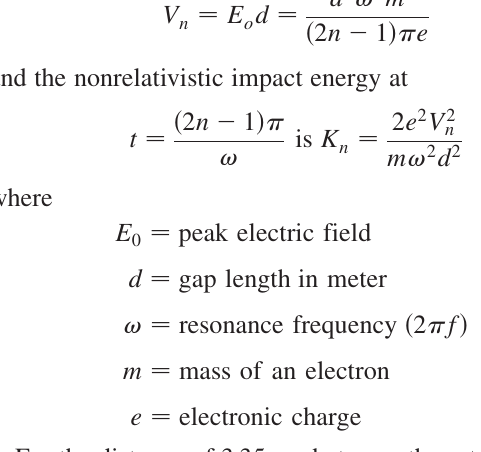
FIG. 5. (Color) Quality factor versus accelerating fields for four QWRs.